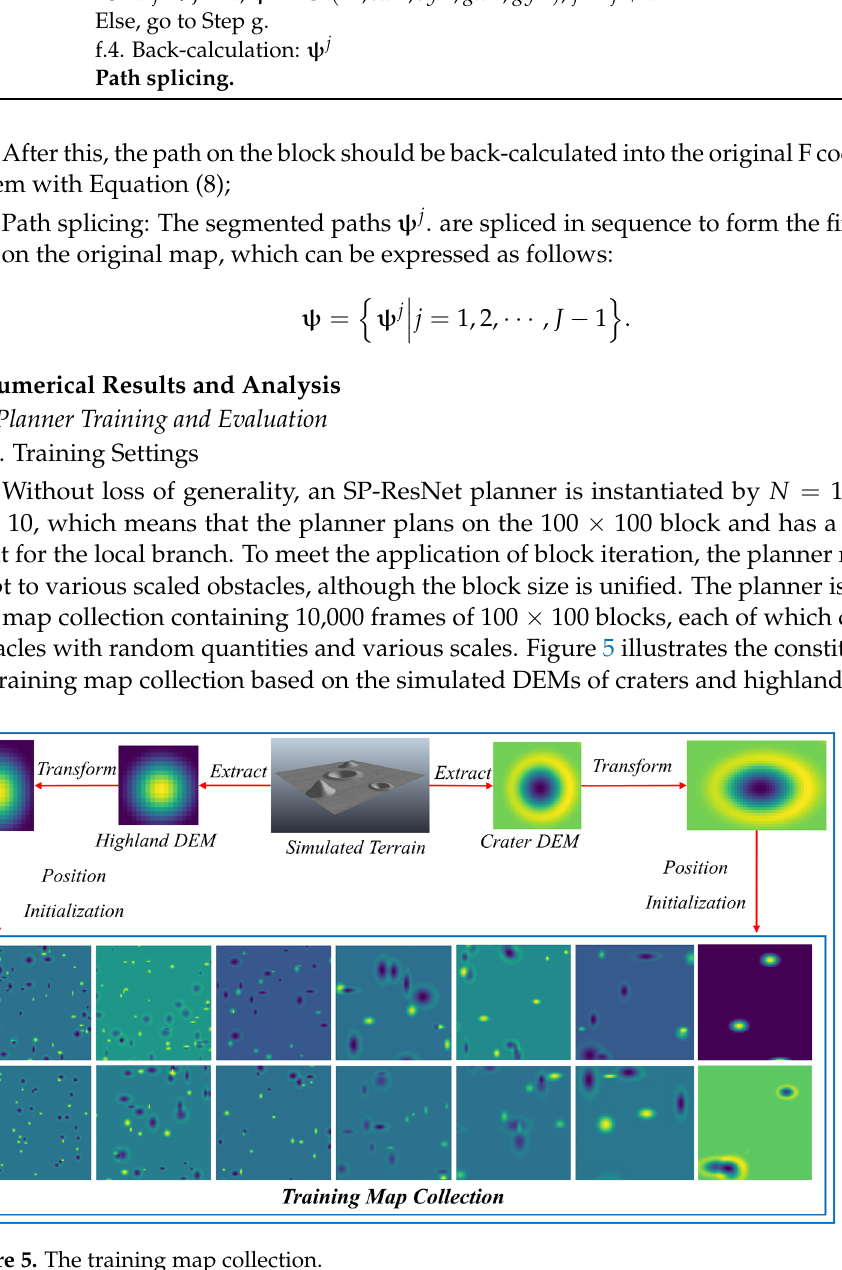
Figure 6. Training curves for the block planner.